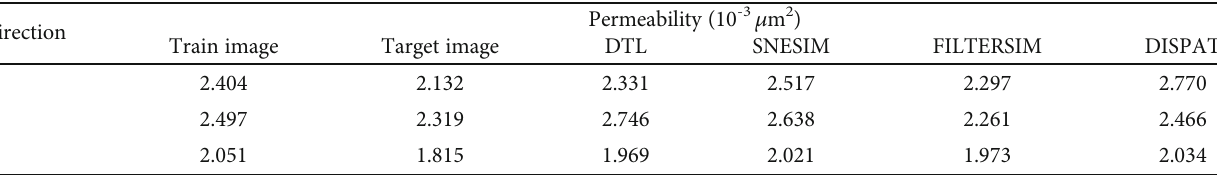
Table 4: Permeability (sandstone) of the TI, the target image, and average permeability of ten reconstructed images in three directions using DTL, SNESIM, FILTERSIM, and DISPAT.